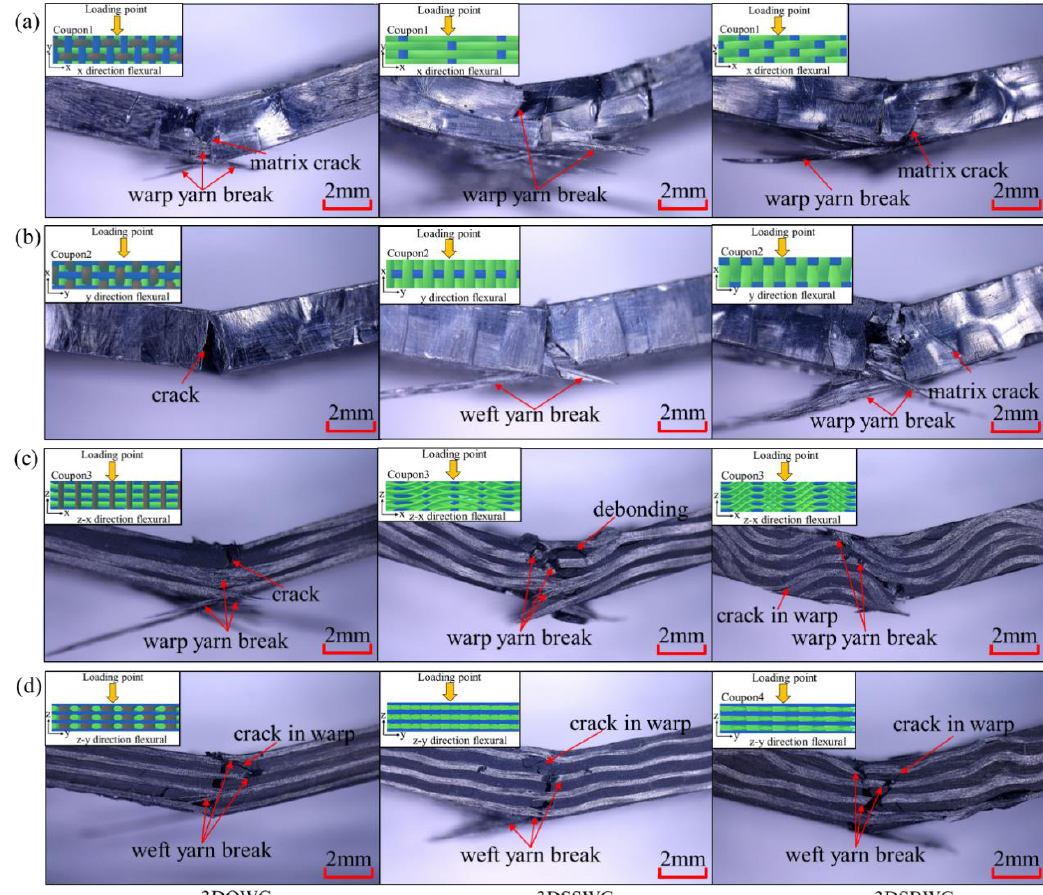
Figure 8. Flexural failure mode in ( a ) x-direction, ( b ) y-direction, ( c ) z-x direction, and ( d ) z-y direction.